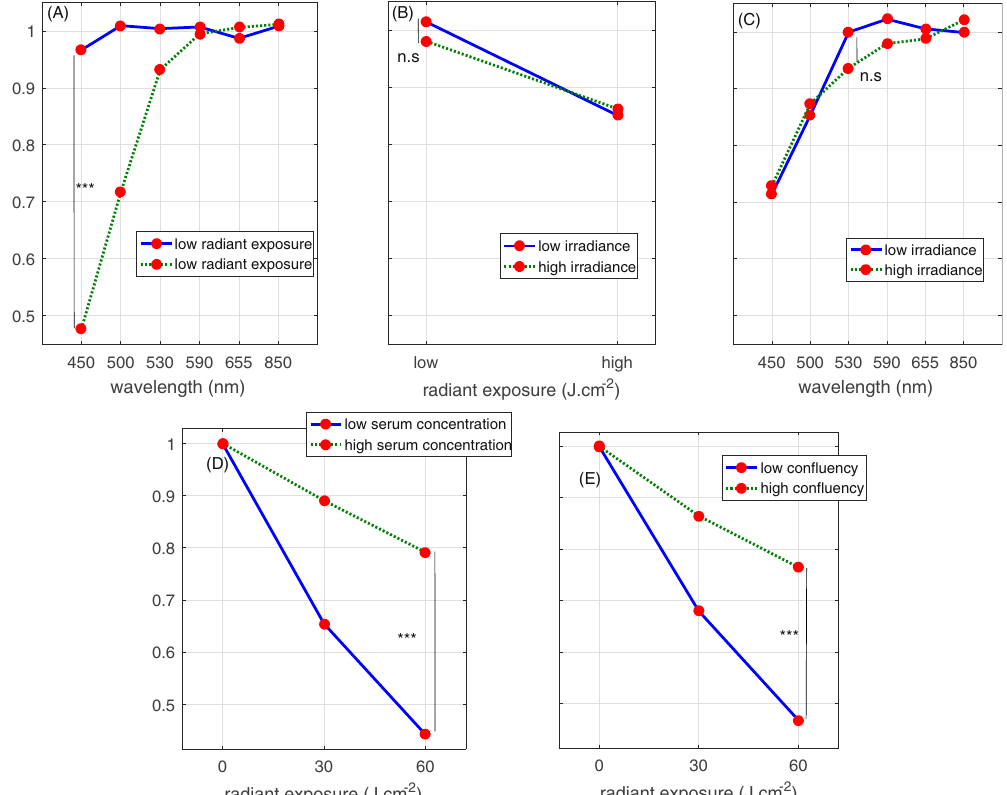
Figure 2. Interactions plot between the wavelength, radiant exposure, irradiance, cell confluency and serum concentration and their relative impact on human dermal fibroblasts metabolic activity. Interactions between wavelength and radiant exposure ( A ), irradiance and radiant exposure ( B ) and irradiance and wavelength ( C ) and their relative impact on human dermal fibroblasts metabolic activity (reticular and papillary). Data points correspond to grand means, i.e. the average value of the metabolic activity for each level of two selected factors (wavelength and radiant exposure, radiant exposure and irradiance or wavelength and irradiance) while all the levels of the remaining factor are averaged. Statistical significance was evaluated using ANOVA (N = 3, 2 lineages and 3 replicates). The levels of radiant exposure correspond to 2 J.cm − 2 (low) and 30 J.cm − 2 (high), the levels of irradiance depended on wavelength and are reported in Table 1 in the Materials and Methods Section. Interactions between levels of radiant exposure of 450 nm light and serum concentration ( D ), and initial confluency ( E ) and their impact on the relative response of the metabolic activity of human dermal fibroblasts. Data points correspond to grand means, i.e. the average value of the metabolic activity for each level of two selected factors (radiant exposure and serum concentration or radiant exposure and confluency) while all the levels of the remaining factor are averaged. Statistical significance was evaluated using ANOVA (N = 2, 2 lineages and 3 replicates). The initial ratio at the moment of seeing between ‘high’ and ‘low’ confluency groups is 5. The control group has an average relative metabolic activity of